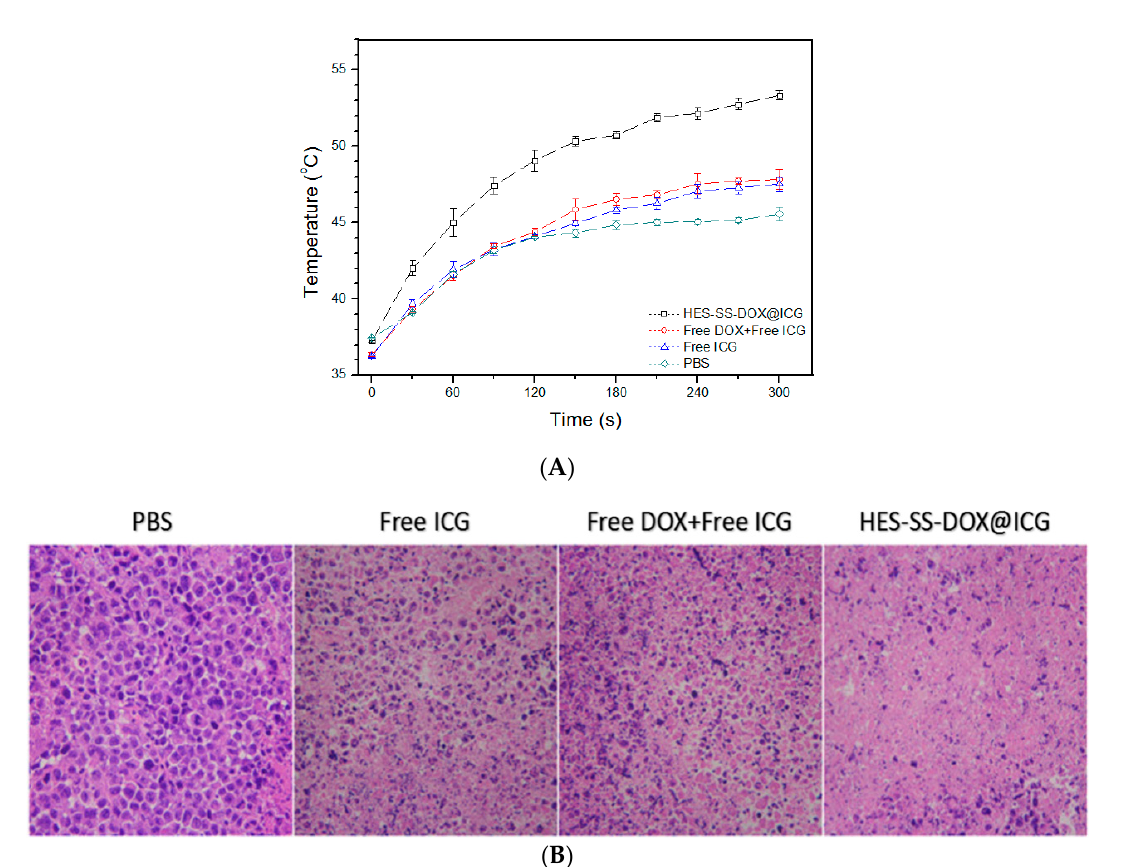
Figure 6. Temperature profiles ( A ) of tumor area of H22-tumor bearing mice treated with different agents for 1 hour and subsequent irradiation for 5 minutes starting at 1 hour after injection and optical micrographs ( B ) of H/E-stained sections for tumors that were excised from the treated mice at one hour post-irradiation (irradiation intensity and time for all involved cases were 0.75 W/cm 2 and 5 min. n = 3, magnification, 200×).